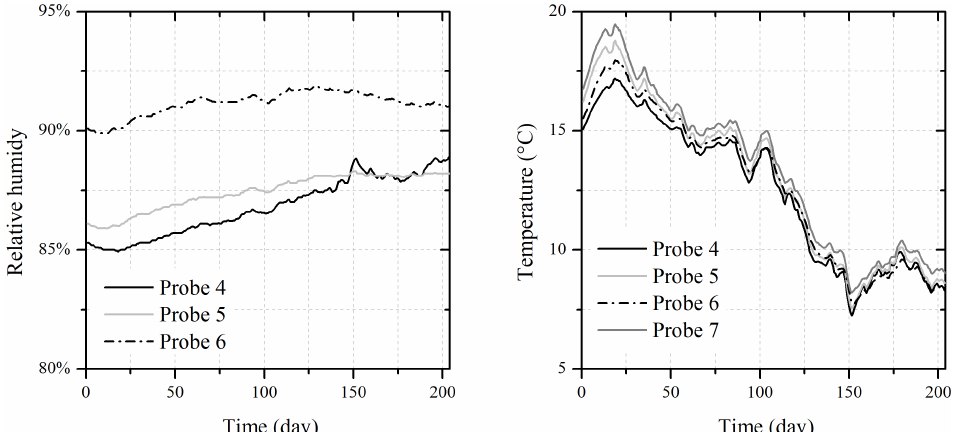
Figure 11. Evolution of relative humidity ( left ) and temperature ( right ) in various depths of the wet wall: Probe 4 is placed at the bottom of the wall, probe 5 at 1m height, probe 6 at 32cm depth and probe 7 at 1.6m height.